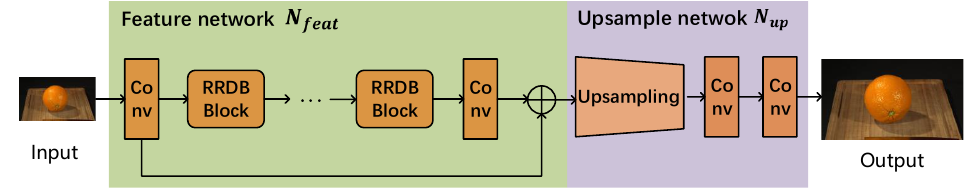
Figure 4. The network structure of the generator network SRResNet.